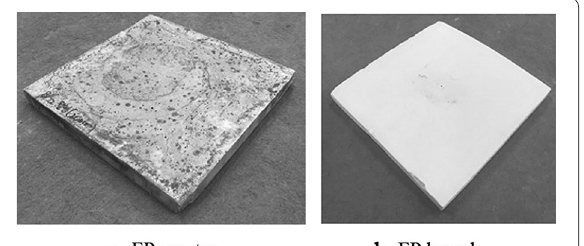
Fig. 23 Mortar and board for thermal conductivity test (Lim et al.